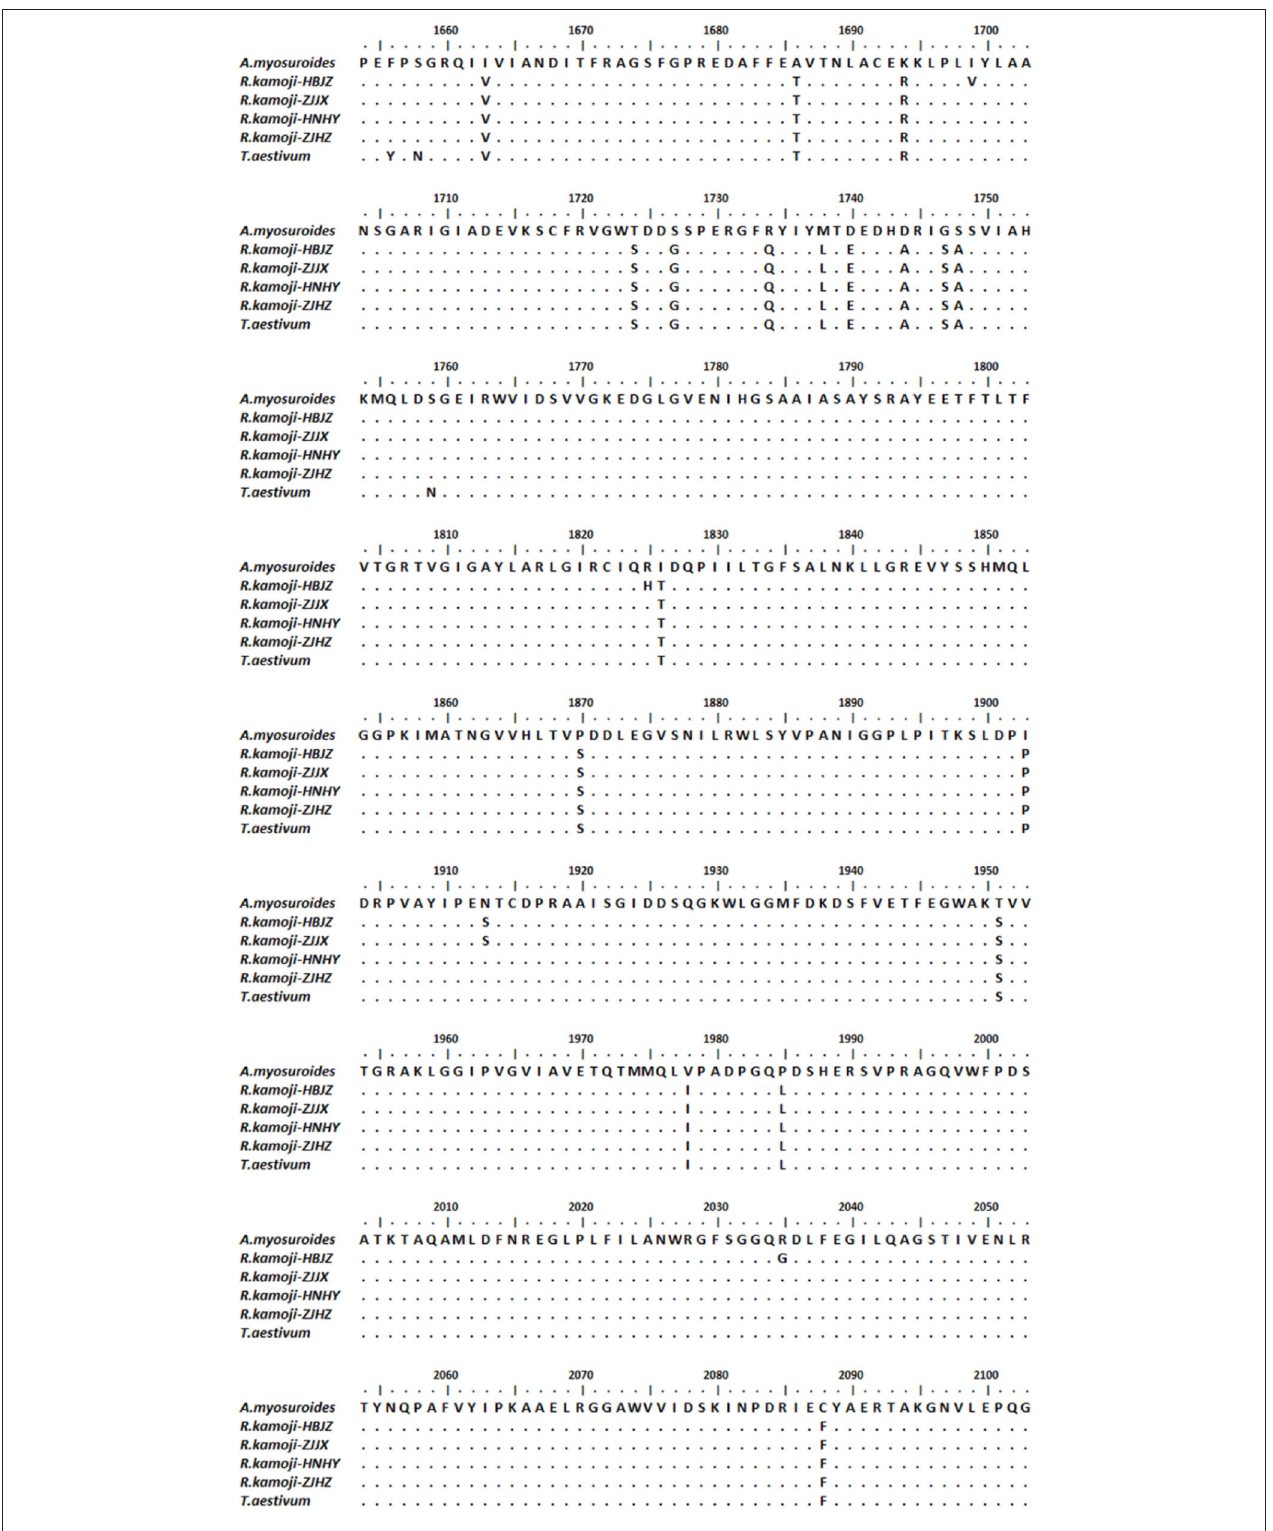
FIGURE 1 | Sequence alignment of a highly conserved region of ACCase gene from four common roegneria populations and blackgrass ( Alopecurus myosuroides Huds., accession number: AJ310767).